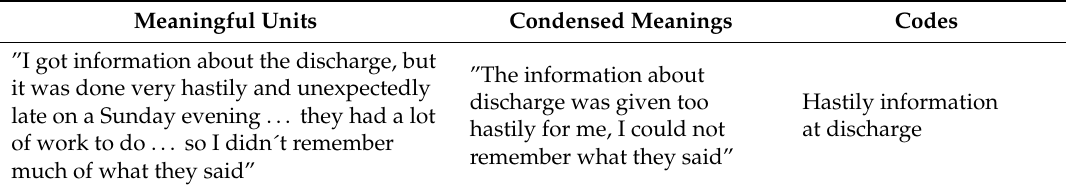
Table 1. Examples of meaningful units, condensed meanings, and